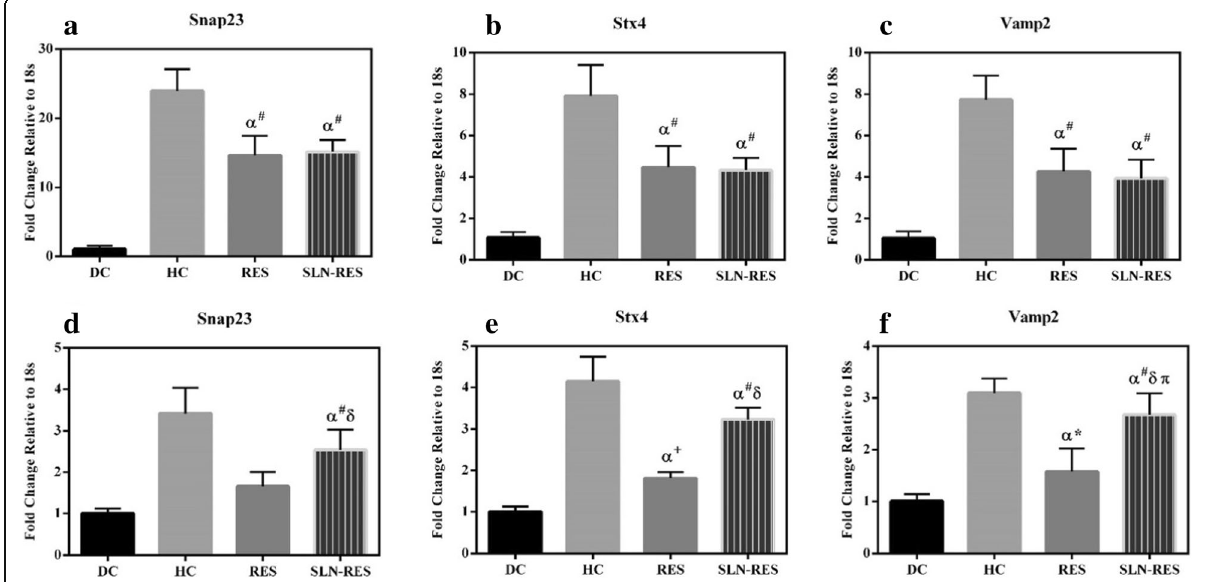
Fig. 4 The effect of RES and SLN-RES treatment on the mRNA level of Snap23, Stx4, and Vamp2 in adipose ( a – c ) and muscle tissue ( d – f ). α , compared to the DC group; δ , there was a significant difference between RES and SLN-RES group ( p < 0.05); π , restored to the HC group (there was no significant difference compared to the HC group ( p > 0.05)). Data were expressed as mean ± SD.* p < 0.05, + p < 0.01, # p <